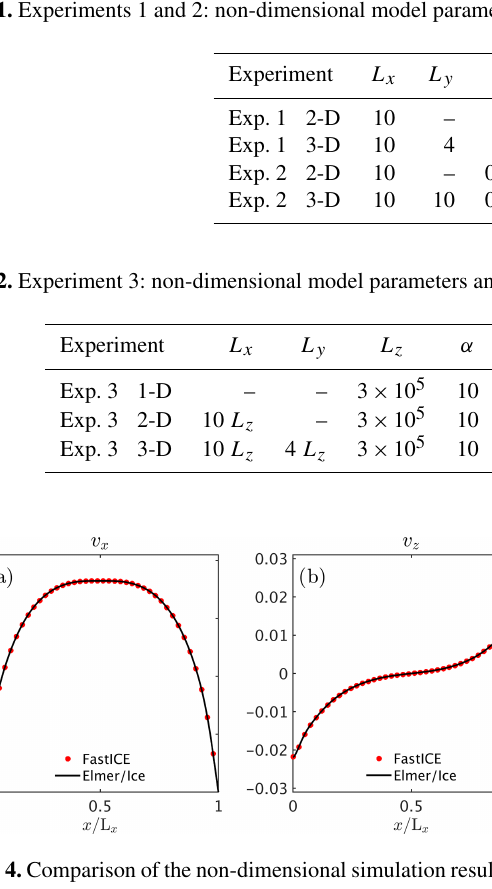
Figure 4. Comparison of the non-dimensional simulation results for the 2-D configuration of Experiment 1. We show (a) the horizontal component of the surface velocity, v x , and (b) the vertical compo- nent of surface velocity, v z , across the ice slab for both our FastICE model and Elmer/Ice. For context, the maximum horizontal veloc- ity ( v x ≈ 0 . 0365) corresponds to ≈ 174myr − 1 . The horizontal dis- tance is 2km, while the ice thickness is 200m. The box is inclined at 10 ◦